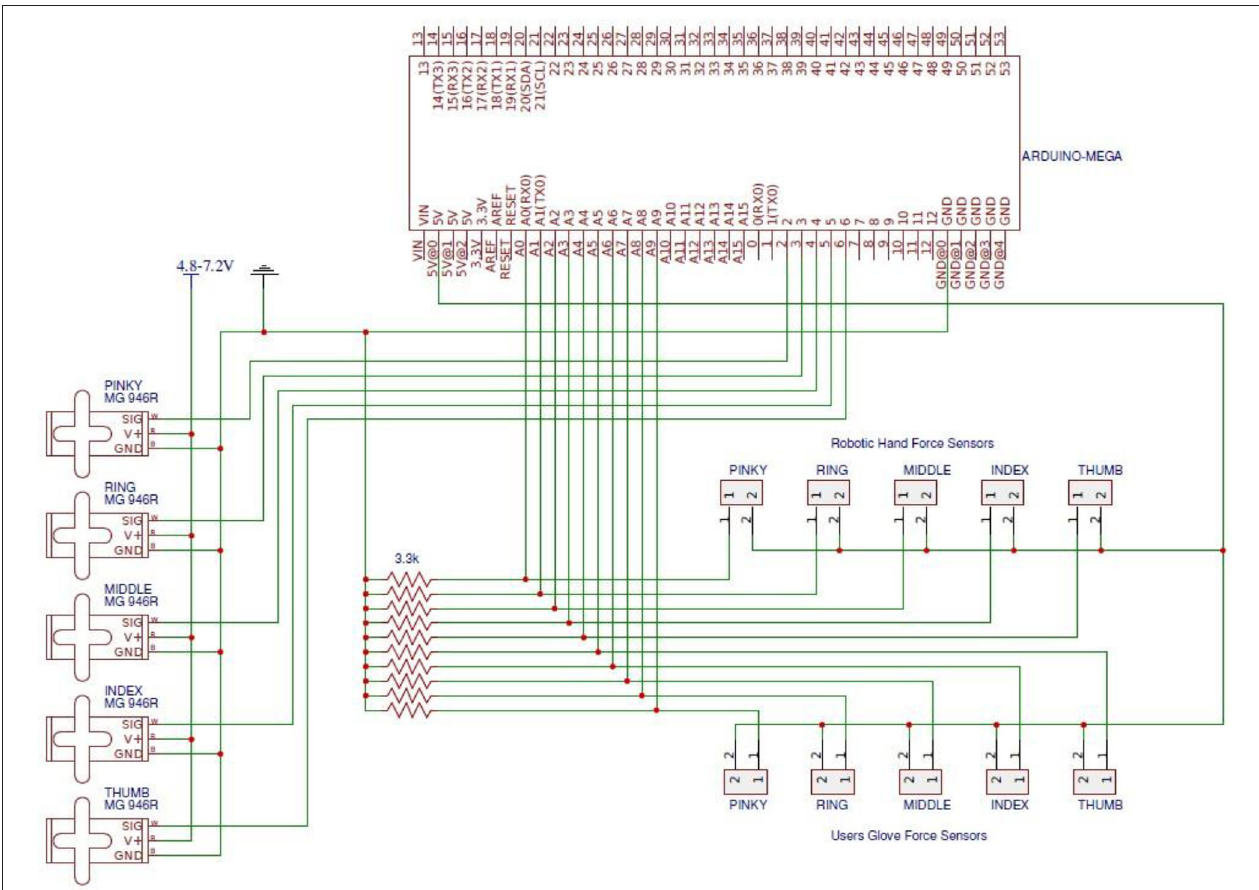
FIGURE 3 | Electrical schematic of the circuit used in the